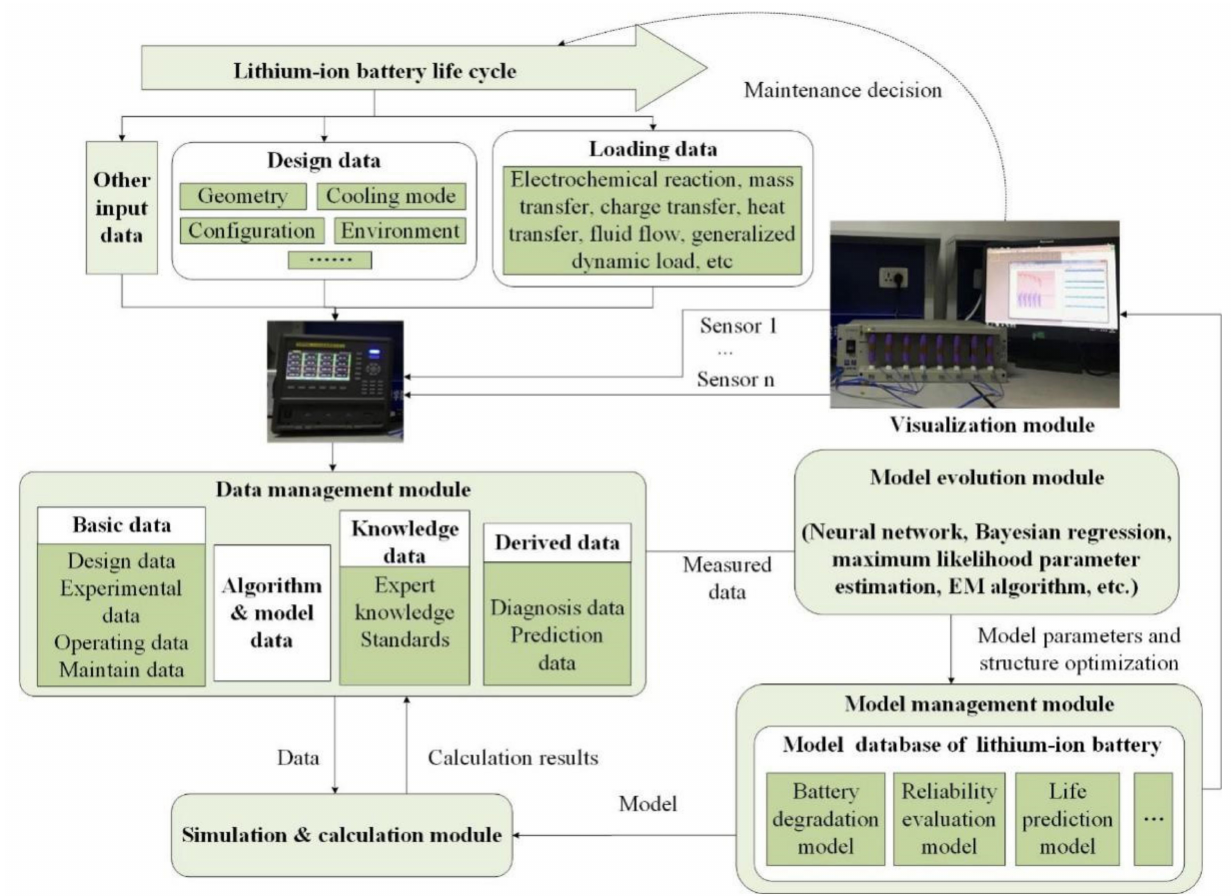
Figure 1. The framework of the digital twin for the reliability of lithium-ion